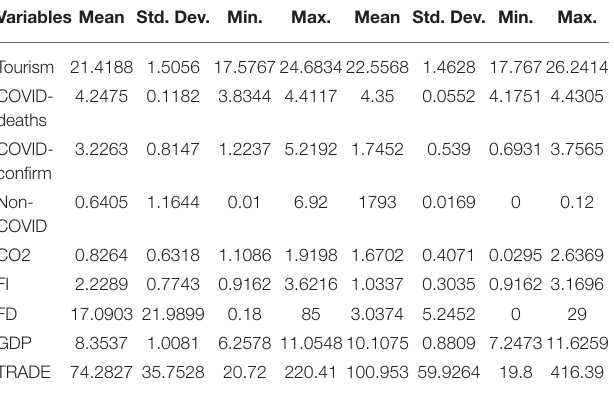
TABLE 1 | Descriptive statistics. Variables Mean Std. Dev. Min.